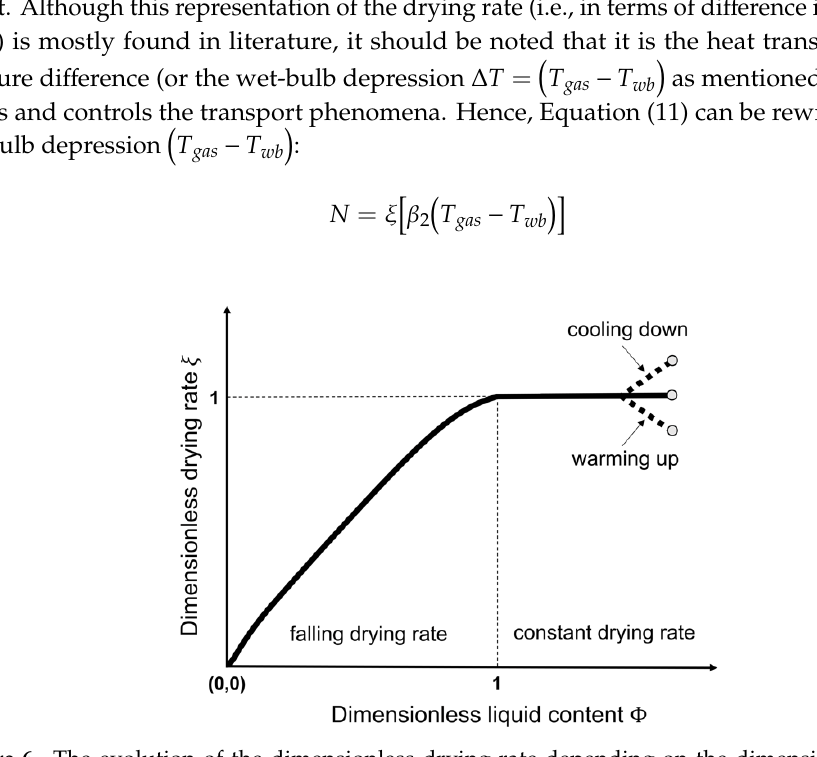
Figure 6. The evolution of the dimensionless drying rate depending on the dimensionless liquid content to give a characteristic drying curve (modified from Chen and van Meel [109,130]).